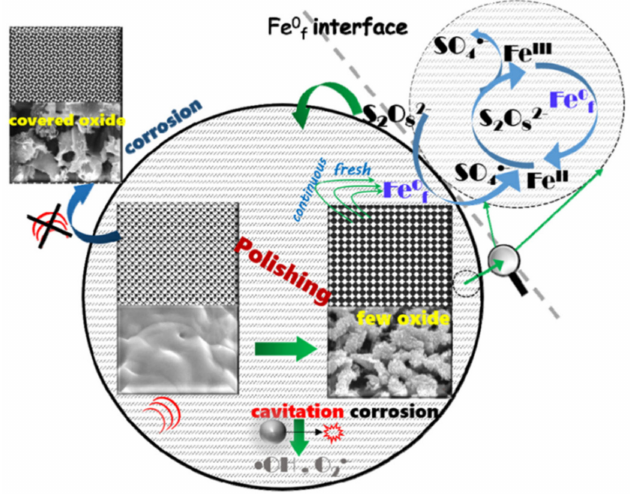
Figure 13. The possible reaction mechanism of US/Fe 0 f –PS [123]. As an activation method of piezoelectric catalysis, an ultrasonic wave is partially used as an example in the Table 6 to degrade different kinds of wastewater through the activation persulfate